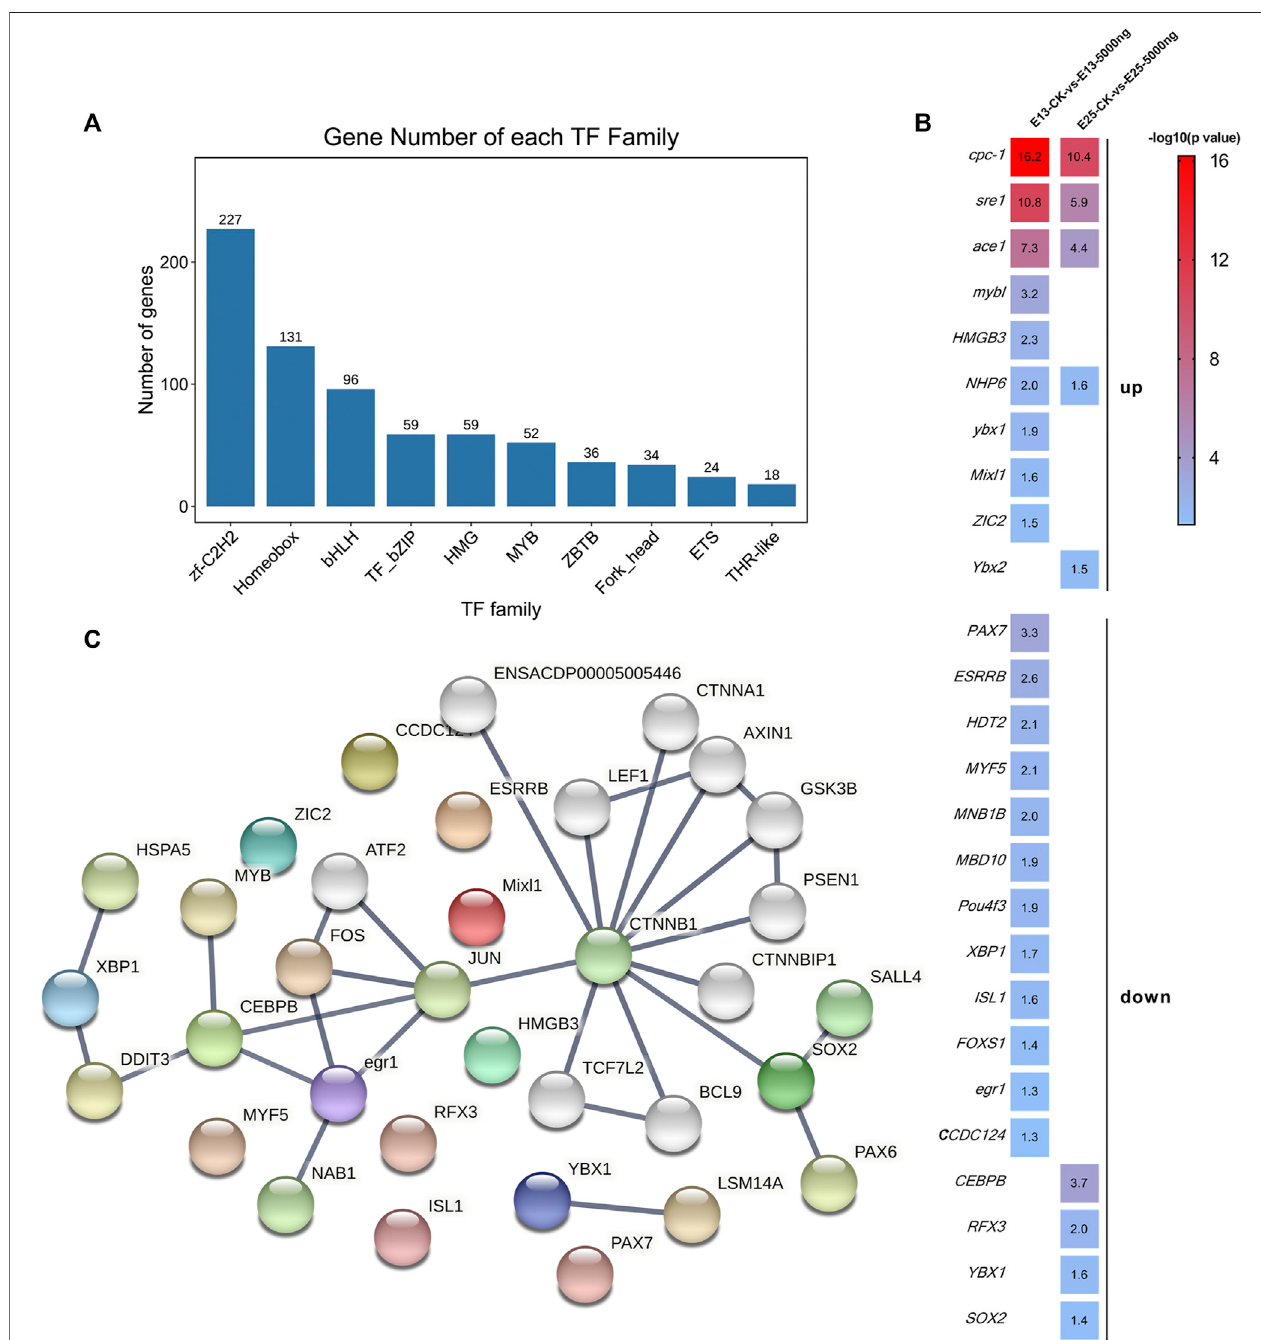
FIGURE 8 | Transcription factors analyses. (A) Families of all transcription factors were detected in this study. (B) Heat map of the shared and unique differentially expressed transcription factors genes as ranked by -log10 ( p -value). (C) PPI network is predicted by the differentially expressed transcription factor genes. n = 3